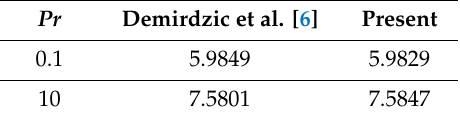
Table 2. Variation of Nu with Pr for Ra = 10 6 compared with the data of Demirdzic et al. [6]. Pr